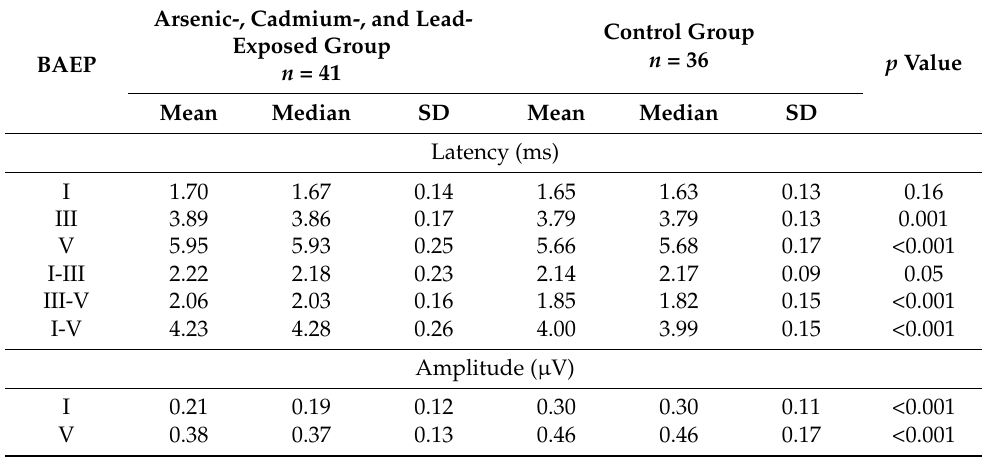
Table 4. Mean values of the latency (ms) and amplitude ( µ V) of brainstem auditory evoked potential (BAEP) parameters in arsenic-, cadmium-, and lead-exposed group patients and in the control group. Arsenic-, Cadmium-, and Lead- Exposed BAEP